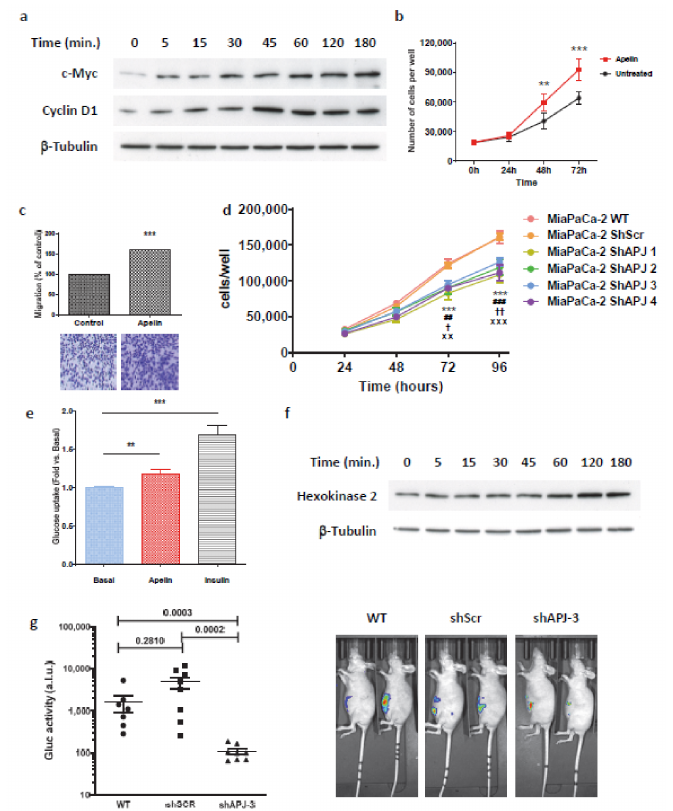
Figure 6. Apelin signaling promotes pancreatic cancer cell proliferation, migration and glucose uptake. Loss of apelin receptor by tumor cells significantly reduces tumor burden. ( a ) Apelin upregulates c-Myc and Cyclin D1 proteins expression. Serum-starved MiaPaCa-2 cells were stim- ulated with Apelin for the indicated times and Western blot analysis of c-Myc, Cyclin D1 and β -tubulin expressions were realized. Representative Western blot from n = 3. ( b ) Apelin treatment induces MiaPaCa-2 cell proliferation ( n = 4). Data represent means ± SEM. Statistical significance between groups was assessed by using 2-way ANOVA followed by Bonferroni post-test. (**) p ≤ 0.01, (***) p ≤ 0.001. ( c ) Apelin (1 µ M) induces MiaPaCa-2 cell migration. Quantification of migration ( n = 5). Mean ± SEM; (***) p ≤ 0.001, Unpaired Student’s t -test. Bottom, representative pictures of crystal violet-colored cells that migrated through the membranes. ( d ) Proliferation of MiaPaCa-2 cells induced by endogenous apelin secretion is fully abolished when MiaPaCa-2 cells stably express an shRNA directed against hAPJ. Data represent means ± SEM. Statistical significance between groups was assessed by using 2-way ANOVA followed by Tukey post-test. *** p < 0.001, MiaPaCa-2 ShAPJ 1 vs. MiaPaCa-2 WT or MiaPaCa-2 ShScr; ## p < 0.01, ### p < 0.001, MiaPaCa-2 ShAPJ 2 vs. MiaPaCa-2 WT or MiaPaCa-2 ShScr; † p < 0.05, †† p < 0.01, MiaPaCa-2 ShAPJ 3 vs. MiaPaCa-2 WT or MiaPaCa-2 ShScr; ×× p < 0.01, ××× p < 0.001, MiaPaCa-2 ShAPJ 4 vs. MiaPaCa-2 WT or MiaPaCa-2 ShScr. ( n = 4). (e) Apelin (1 µ M) promotes glucose uptake in MiaPaCa-2 cells. Insulin (1 µ M) was assessed as a positive control. Mean ± SEM; (**) p ≤ 0.01, (***) p ≤ 0.001, Unpaired Student’s t -test. ( n = 7). (f) Apelin upregulates Hexokinase II protein level in pancreatic tumor cells. Representative Western blot from n = 3. (g) Deletion of hAPJ in tumor cells abolishes tumor burden in a murine orthotopic xenograft assay. MiaPaCa-2 cells stably expressing shRNA directed against hAPJ (shAPJ 3) or a control shRNA (shScr) and secreting Gaussia luciferase (Gluc) were injected in the pancreas of Swiss nude mice ( n = 8 mice per group). Gluc levels were measured in mice serum in the last week of the study period and mice were imaged using IVIS Spectrum. The results are the mean of Gluc activities after 47 days burden ( ± SEM) and are expressed as Arbitrary Light Unit (A.L.U.). Statistical significance was assessed using Mann–Whitney